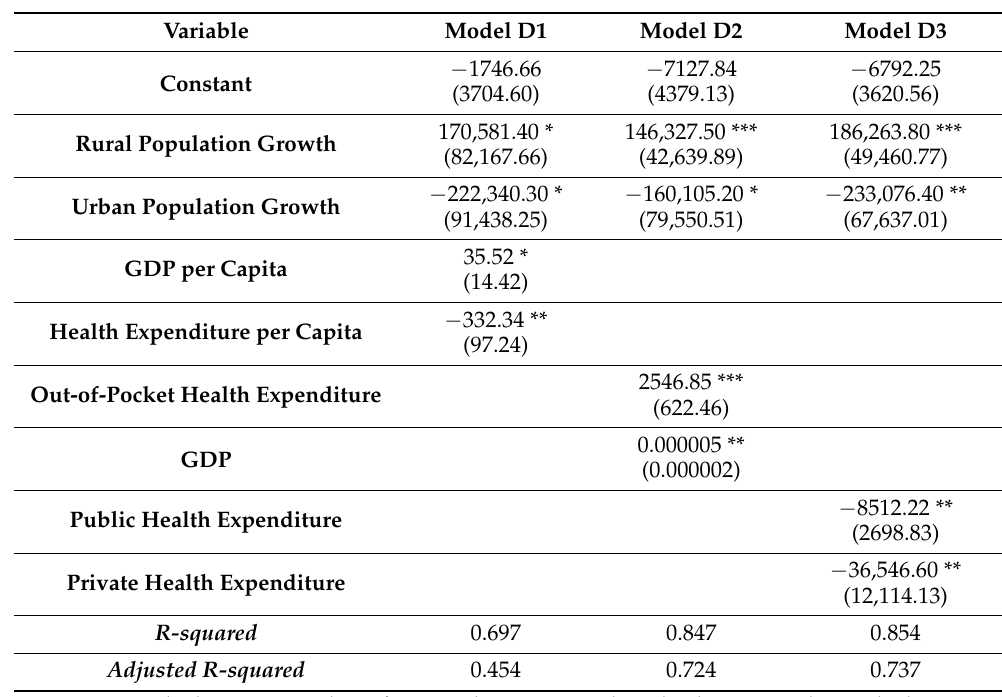
Table 2. Factors influencing the number of cases of diarrhea in Jordan (years